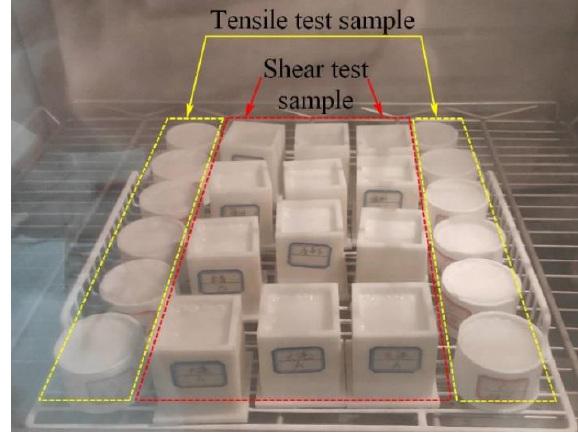
Figure 11. Shear test ice sample and tensile test ice sample in mold.